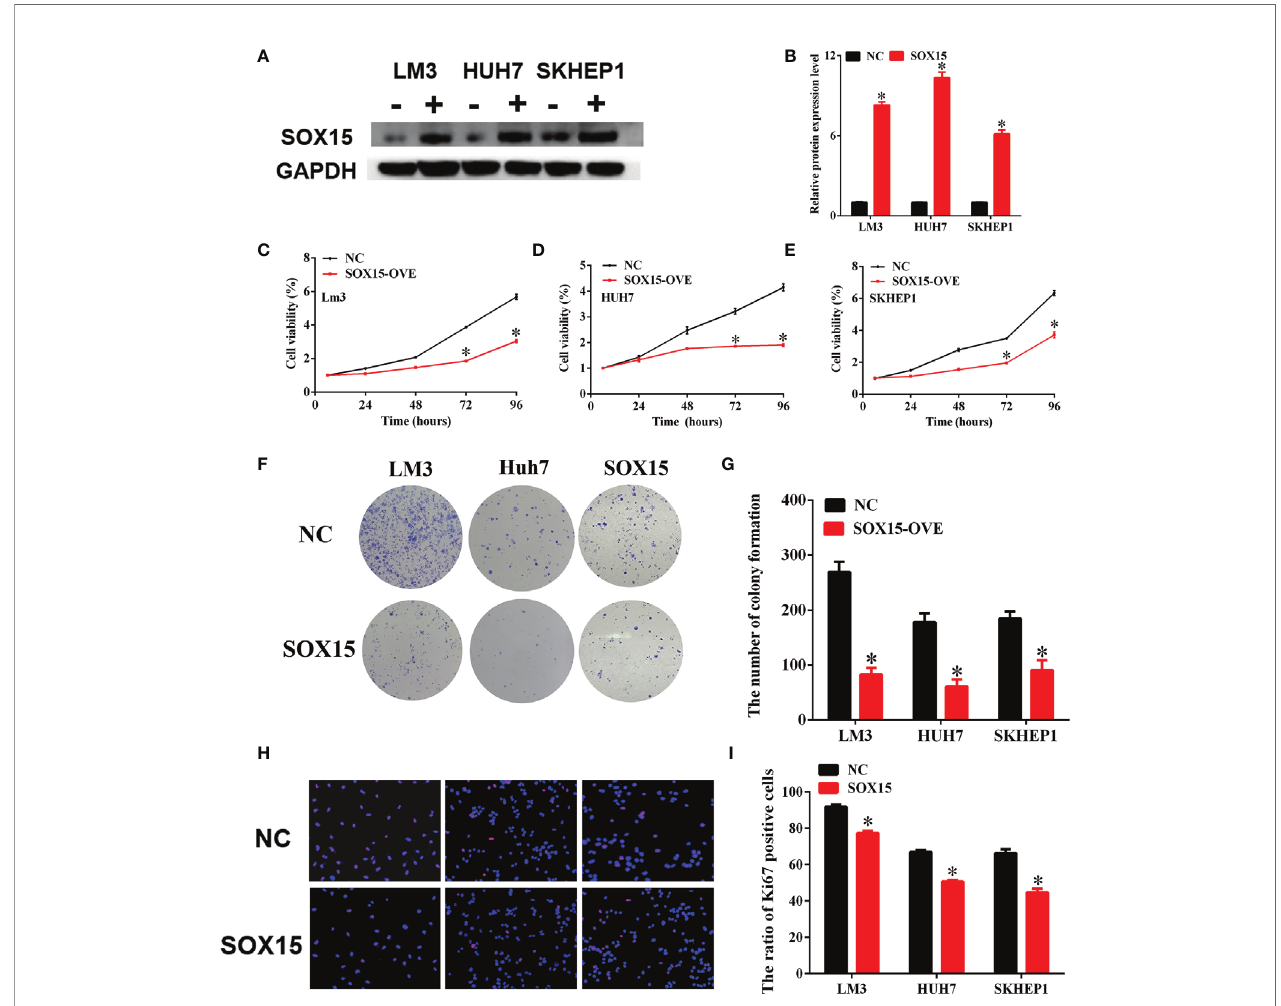
FIGURE 5 | Sox15 inhibits the in vitro growth of HCC cells. (A, B) Sox15 overexpression ef fi ciency in HCC cell lines detected through WB assay and quanti fi cation. (C – E) Role of Sox15 overexpression in HCC cell viability measured by CCK-8 assay. (F, G) Role of Sox15 overexpression in the clone-forming capacity of HCC cells and quanti fi cation. (H, I) Role of Sox15 overexpression in HCC cell viability measured by Ki67 IHC and quanti fi cation. *p <